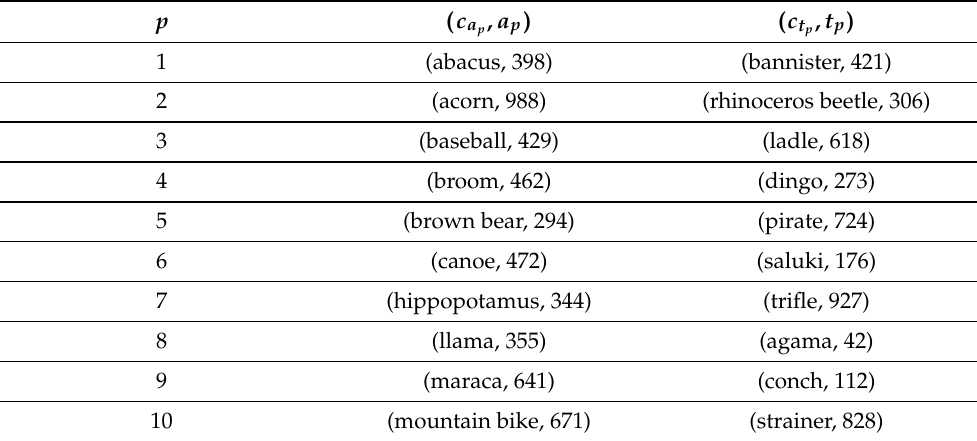
Table 1. For 1 ≤ p ≤ 10, the second column lists the ancestor category c a among the categories of ImageNet. Mutatis mutandis in the third column with the target category c t and ordinal t p